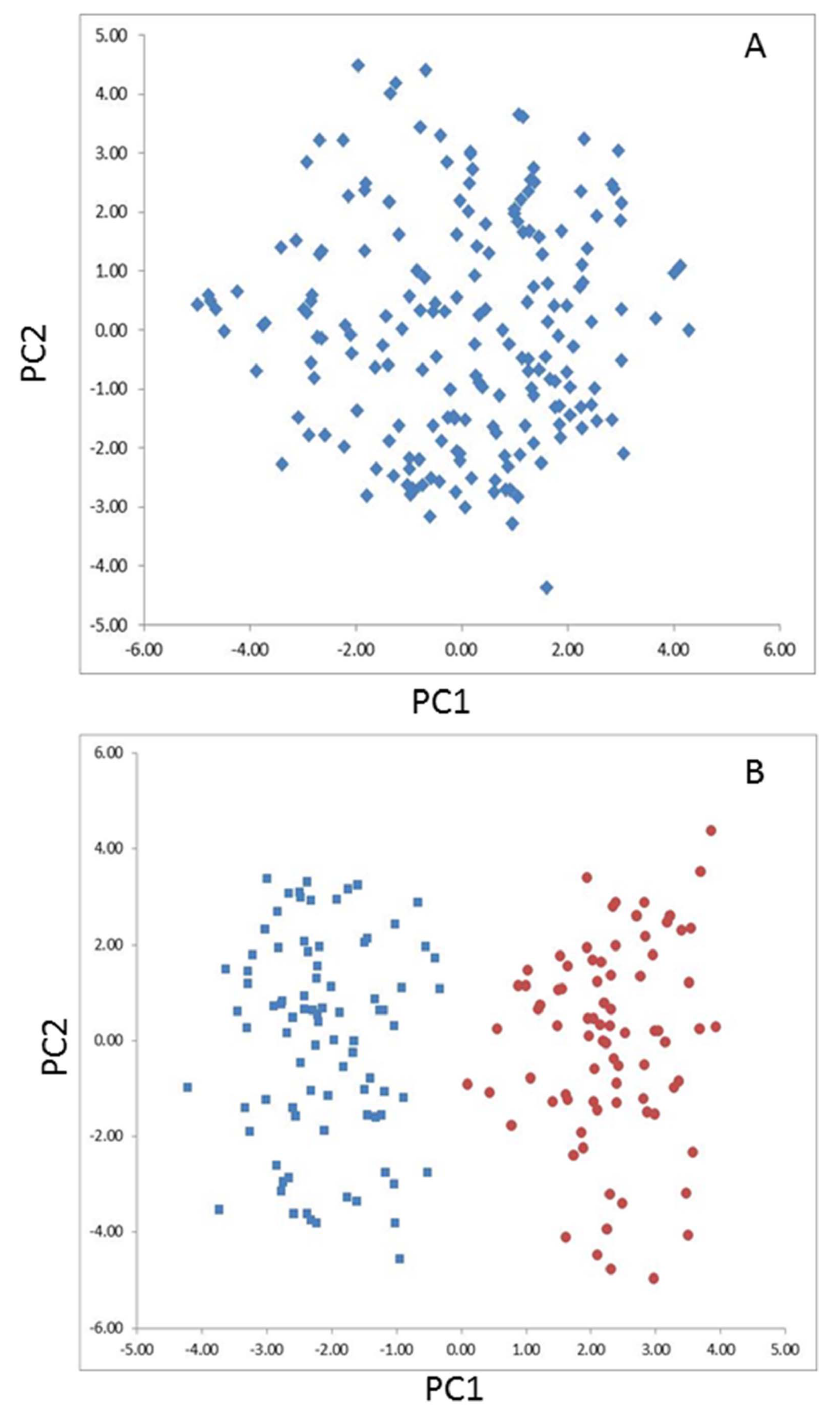
Fig. 4. Principal components analysis of marker data in the Pioneer (A) and Alforex populations (B). The first and second principal components were used for graphing. Each data point represents a genotype. No subpopulation was detected in the Pioneer population (A), while two clusters were distinguishable in the Alforex population (B).